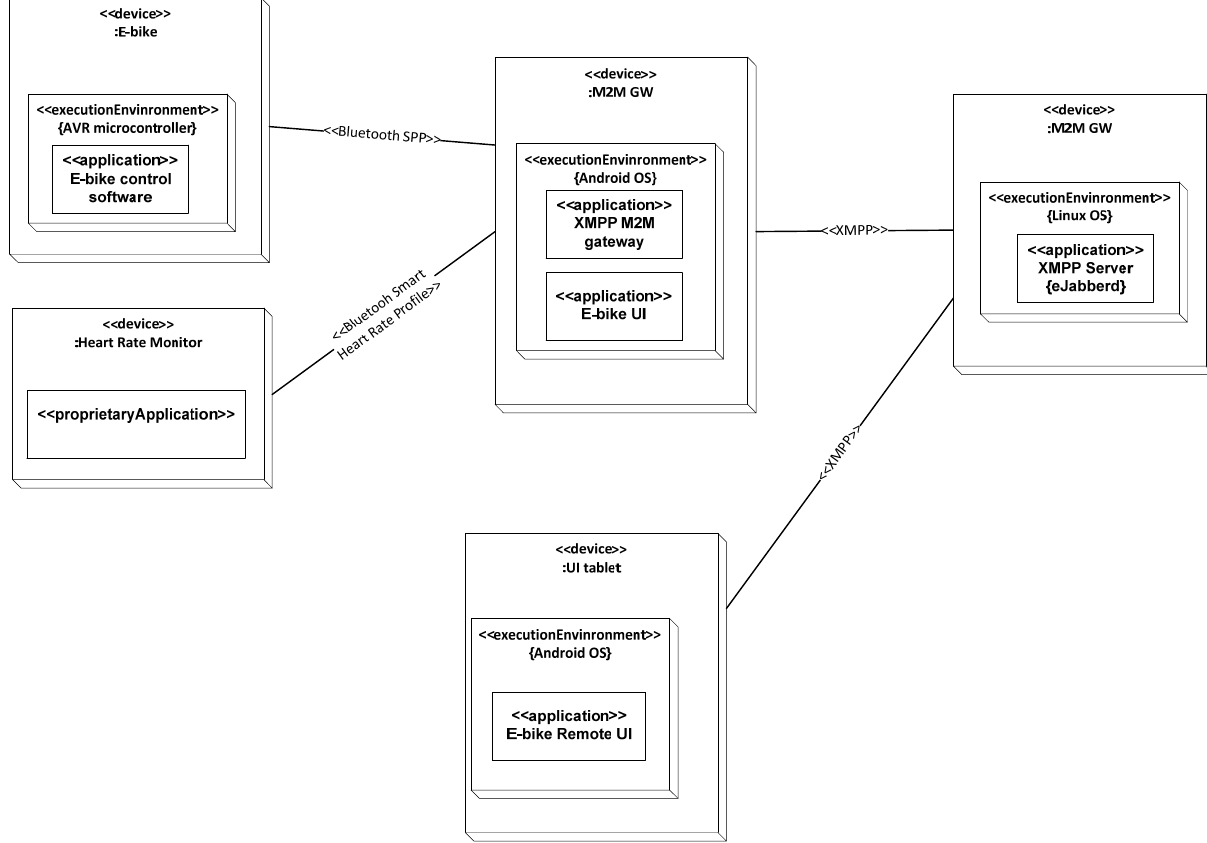
Figure 25. Deployment diagram of electric bike